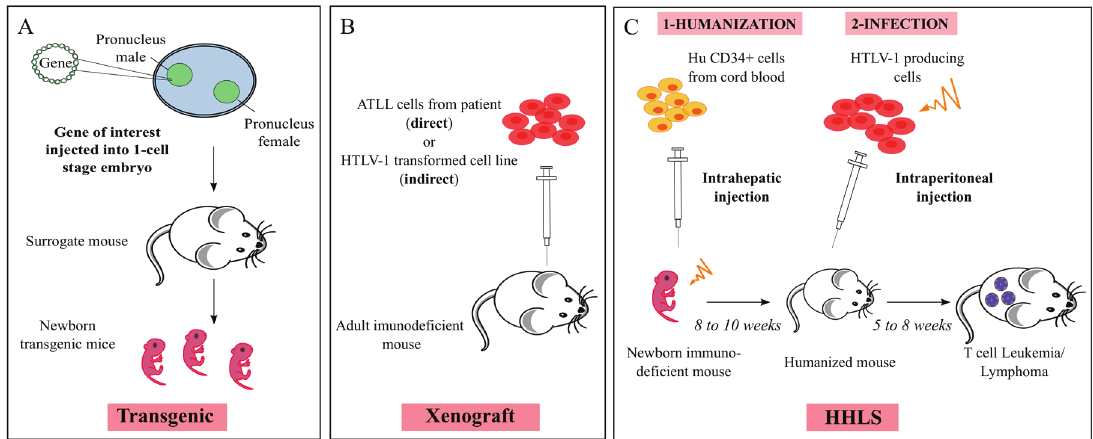
Figure 2. Schematic representation of the protocols used to generate HTLV-1 mouse models. ( A ) Generation of a transgenic mouse model. Briefly, the gene of interest is injected into the male pronucleus of a one-cell embryo. Micro-injected oocytes are introduced into a surrogate female and carried to term. The resulting offspring will then be screened by PCR and sequenced to find the transgenic ones; ( B ) Generation of direct and indirect xenograft mouse models: adult immunodeficient mice are injected either with cells isolated from ATLL patients (direct xenograft) or with HTLV-1 transformed cells (indirect xenograft); ( C ) Generation of Human Hemato-Lymphoid System (HHLS) mouse model: sublethally irradiated newborn immunodeficient mice are engrafted with hematopoietic stem cells. Those humanized mice are then infected with lethally irradiated HTLV-1 producing T cells (see Section 5.2.).